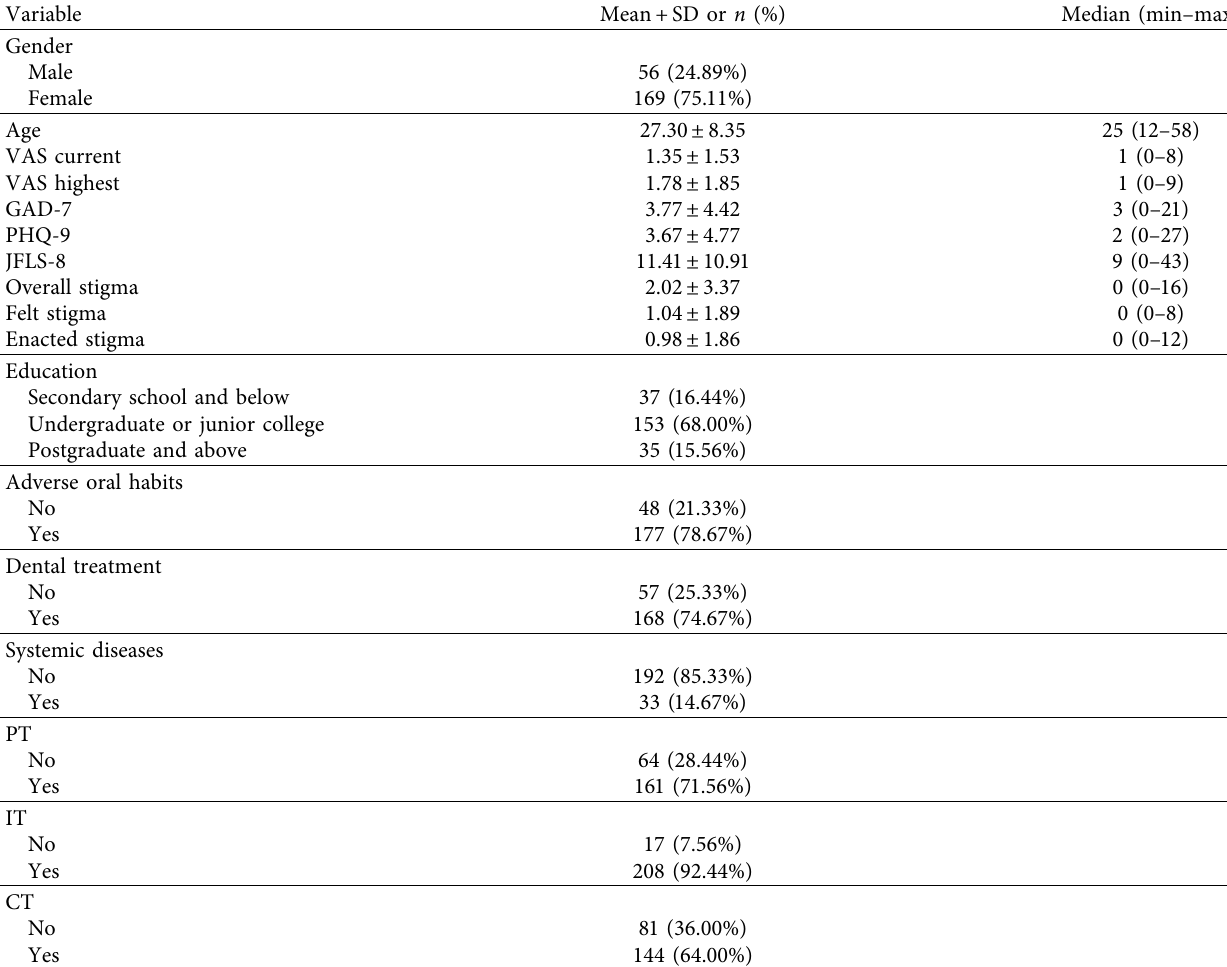
Table 1: Sociodemographic and clinical characteristics of the